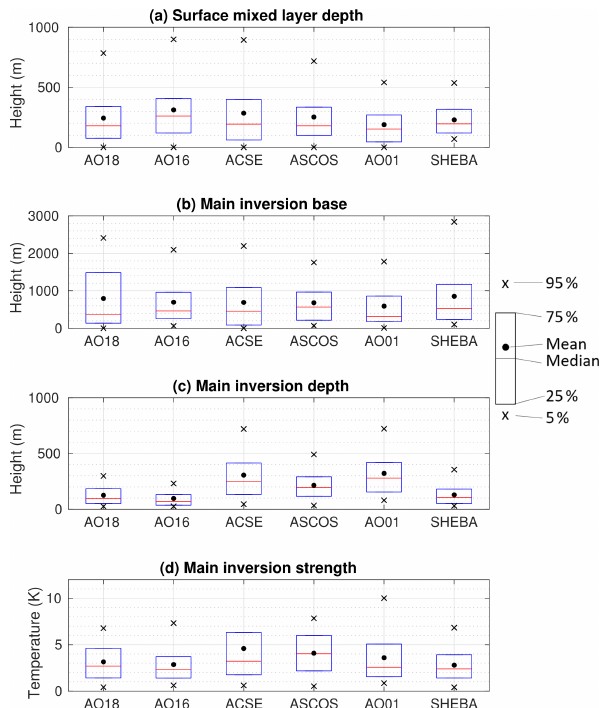
Figure 19. Statistics on surface mixed layer depth, main inver- sion base height, strength, and depth for six campaigns: AO2018, AO2016, ACSE, ASCOS, AOE2001 and